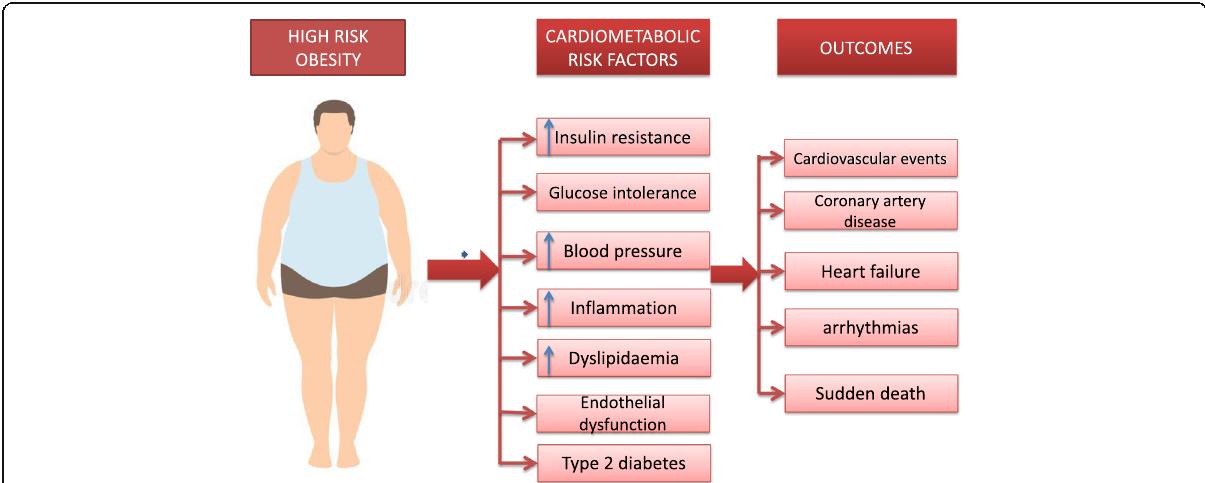
Fig. 1 Relationships between high-risk obesity, intermediate cardiometabolic risk factors, and cardiovascular outcomes (obesity phenotypes, diabetes, and cardiovascular